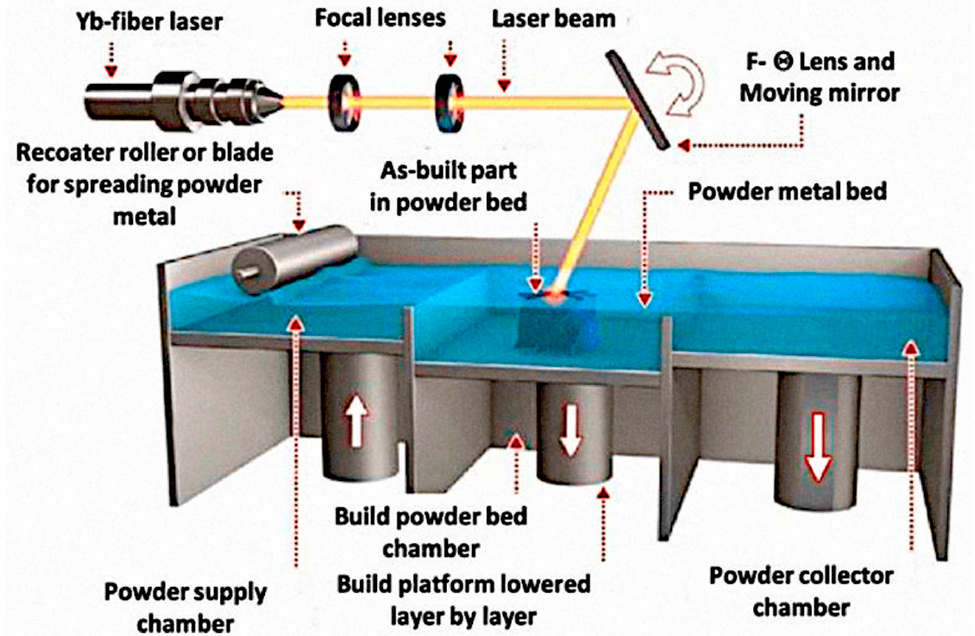
Figure 12. Schematic representation of the L-BPF process [51].